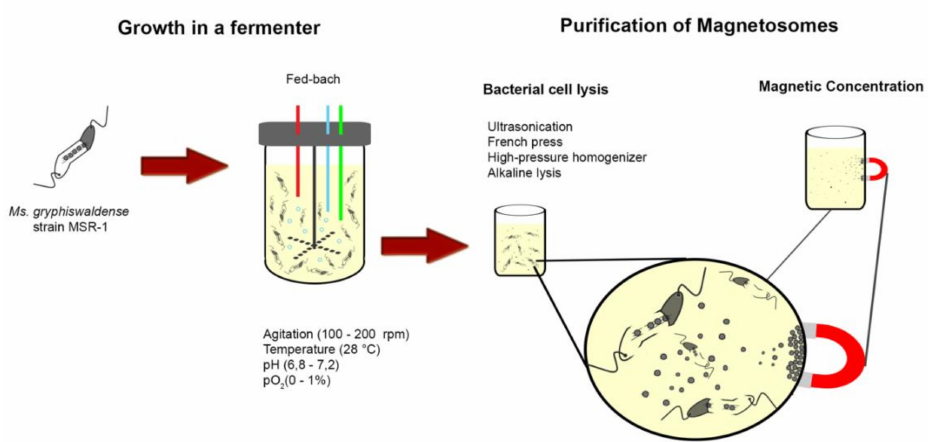
Figure 5. Illustrative scheme of magnetosome purification. Cells of Magnetospirillum gryphiswaldense strain MRS-1 are grown in a fermenter and then lysed using different methods and magnetosomes purified from lysed cells using magnetic concentration and separation. This scheme is based on numerous studies